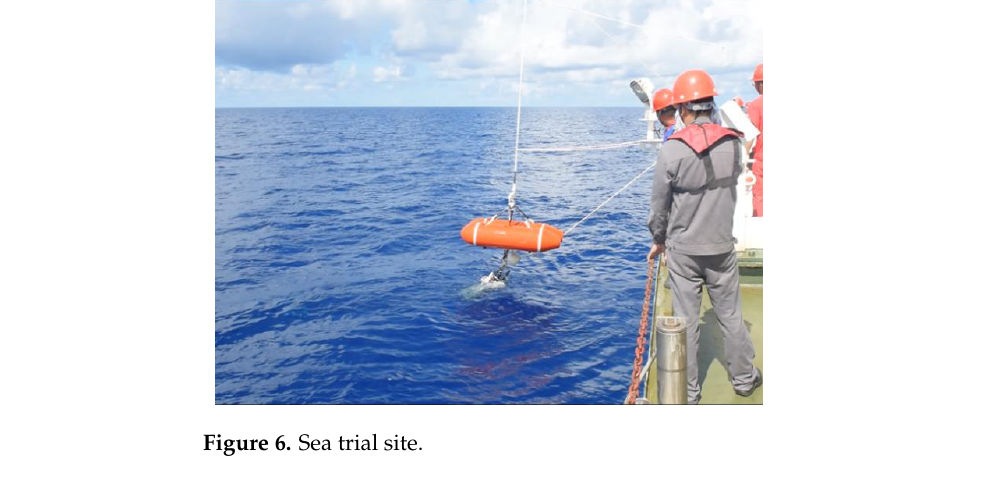
Figure 6. Sea trial site.